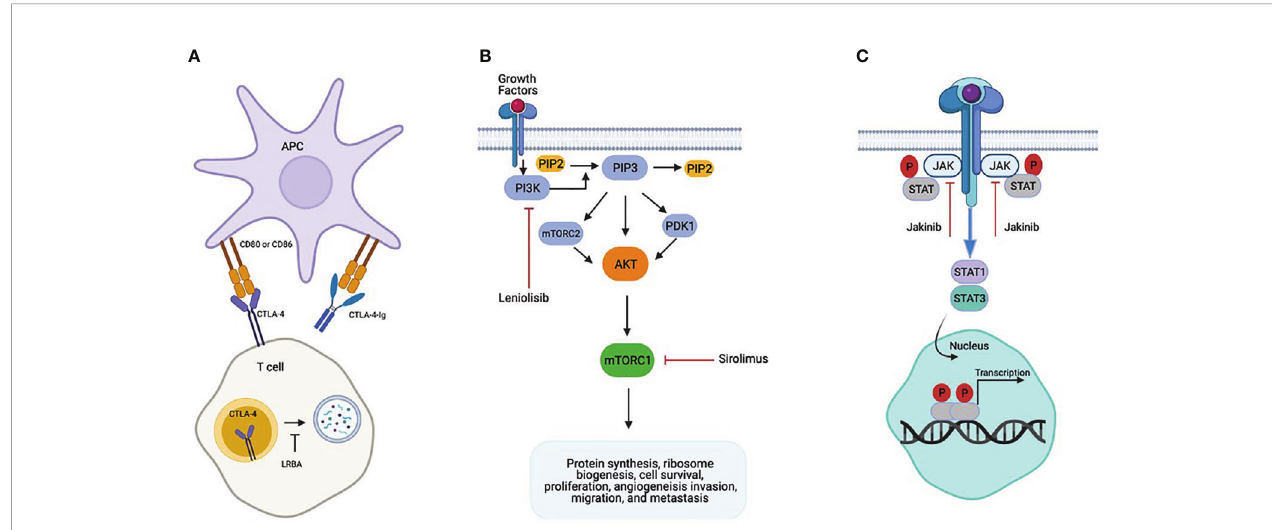
FIGURE 1 | Biology of Precision Based Therapies. (A) CTLA4-Ig binds to CD80/86 effectively replacing the non-functional CTLA-4 protein. (B) Gain of Function mutations in PIK3CD or PIK3RI result in Activated PI3K d Syndrome. Leniolisib inhibits PI3K activation directly and sirolimus inhibits downstream enhanced mTORC1 activity. (C) Gain of function mutations in STAT1 and STAT3 cause hyperactivation STAT1 and STAT3 respectively. Jakinibs are direct inhibitors of the JAK/STAT